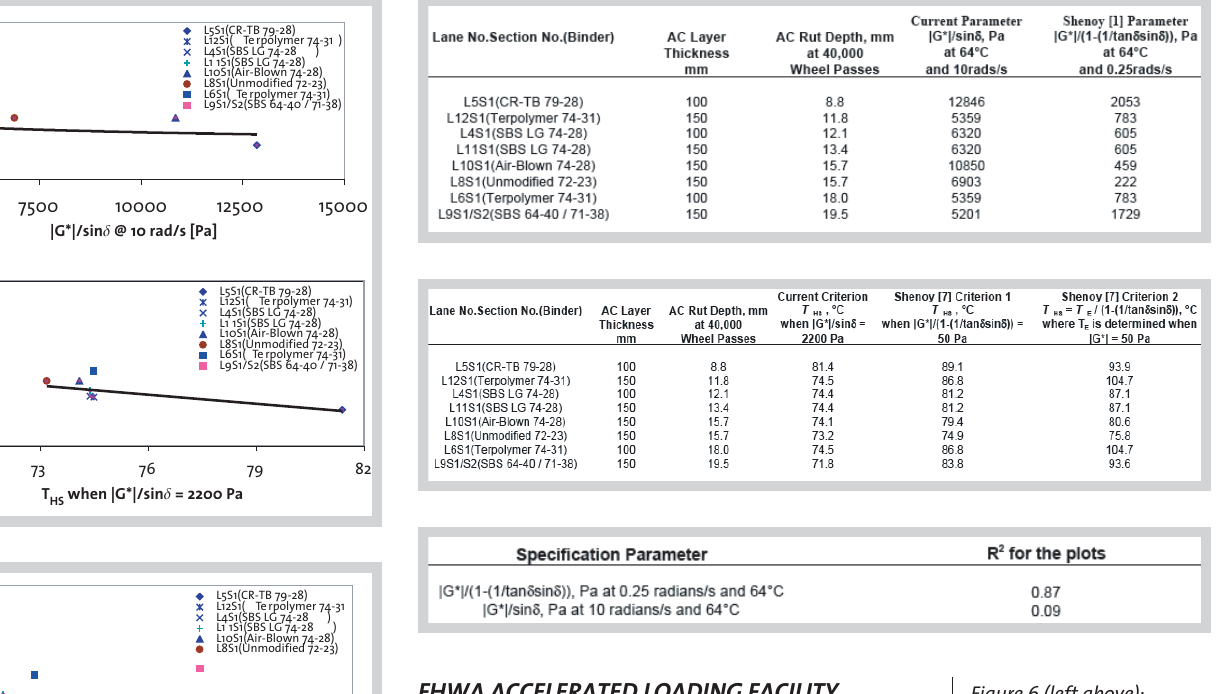
Figure 6 (left above): Comparison of the predictions of the Superpave specification parameter |G*|/sin d with AC rut depths for ALF-2 Project (Consider- ing data from thick and thin pavements and 2 outliers). Figure 7 (left below): Comparison of the predictions of the parame- ter |G*|/(1-(1/tan d sin d )) with AC rut depths for ALF-2 Project (Considering data from thick and thin pavements and 2 outliers). Table 5 (right above): Comparison of |G*|/sin d and |G*|/(1-(1/tan d sin d )) with AC rut depth at 40,000 wheel passes for asphalt binders from the ALF-2 Project. Table 6 (right middle): Comparison of the high specification temperature T HS for |G*|/sin d and the two criteria for |G*|/(1-(1/tan d sin d )) with AC rut depth at 40,000 wheel passes for asphalt binders from the ALF-2 Project. Table 7a (right below): Correlation coefficients for |G*|/sin d and |G*|/(1-(1/tan d sin d )) with AC rut depth at 40,000 wheel passes for asphalt binders from the ALF-2 Project (Considering thick and thin pavements and 2